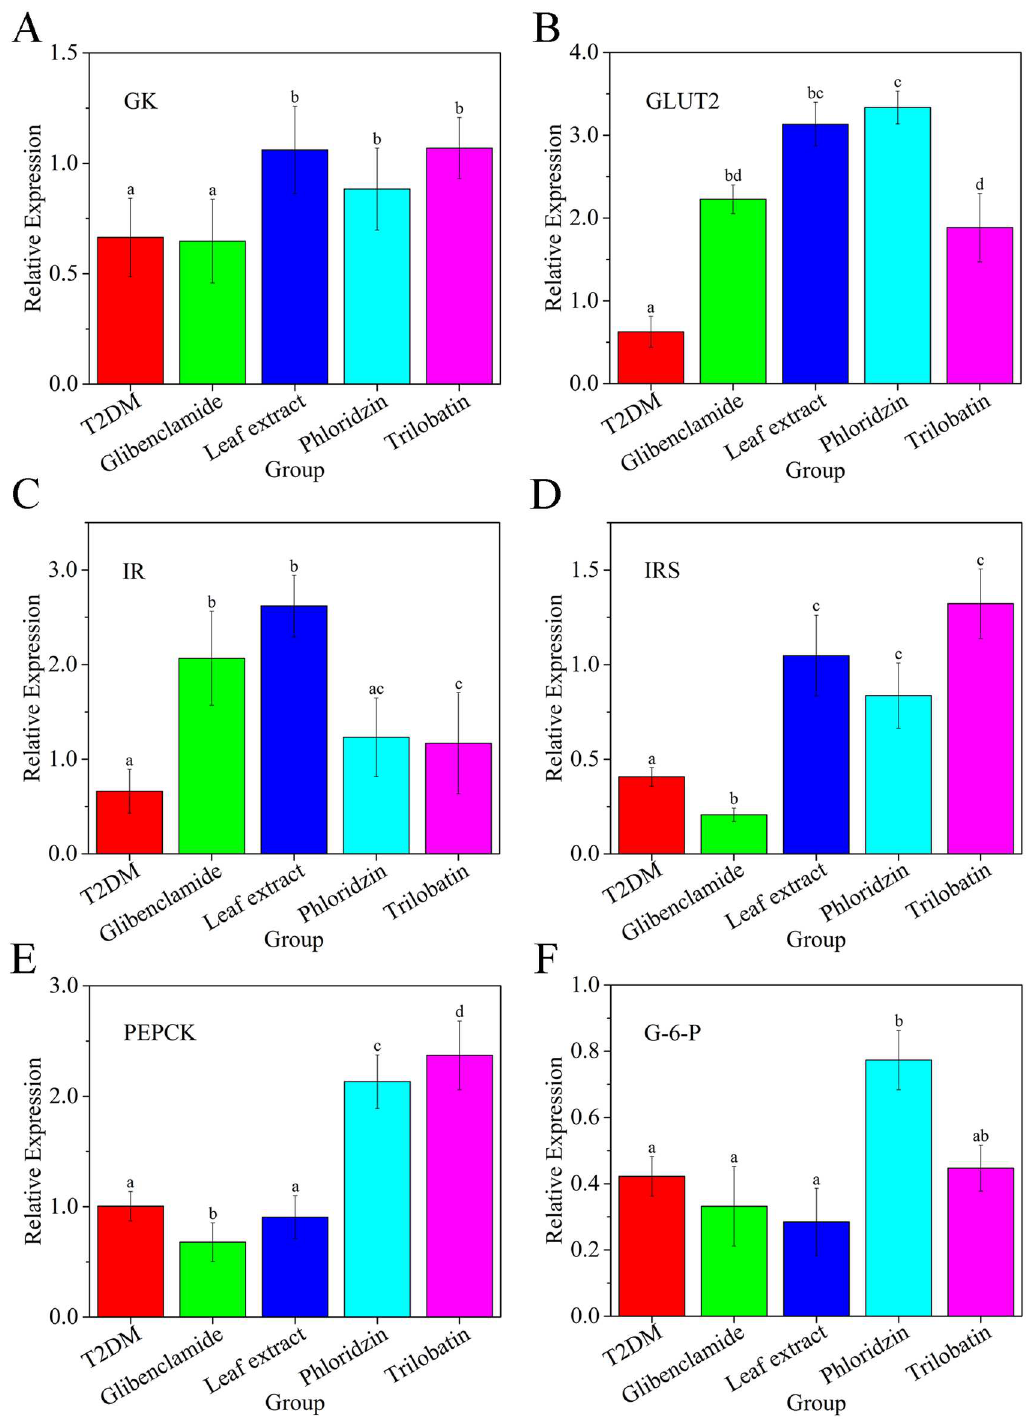
Fig 8. Effect of L . polystachyus Rehd. leaf extractson relative expression for T2DM group. (A) glucokinase (GK), (B) glucosetransport 2 (GLUT2), (C) insulinreceptor (IR), (D) insulinreceptorsubstrate (IRS), (E) phosphoenolpyruvate carboxykinase(PEPCK), and (F) glucose-6-phosphatase (G-6-P). The data were analyzedwith ANOVA. Relativeexpressionvalues are expressedas the mean ± SEM, n = 6. Columns labeled with different letters are significantly different at P <